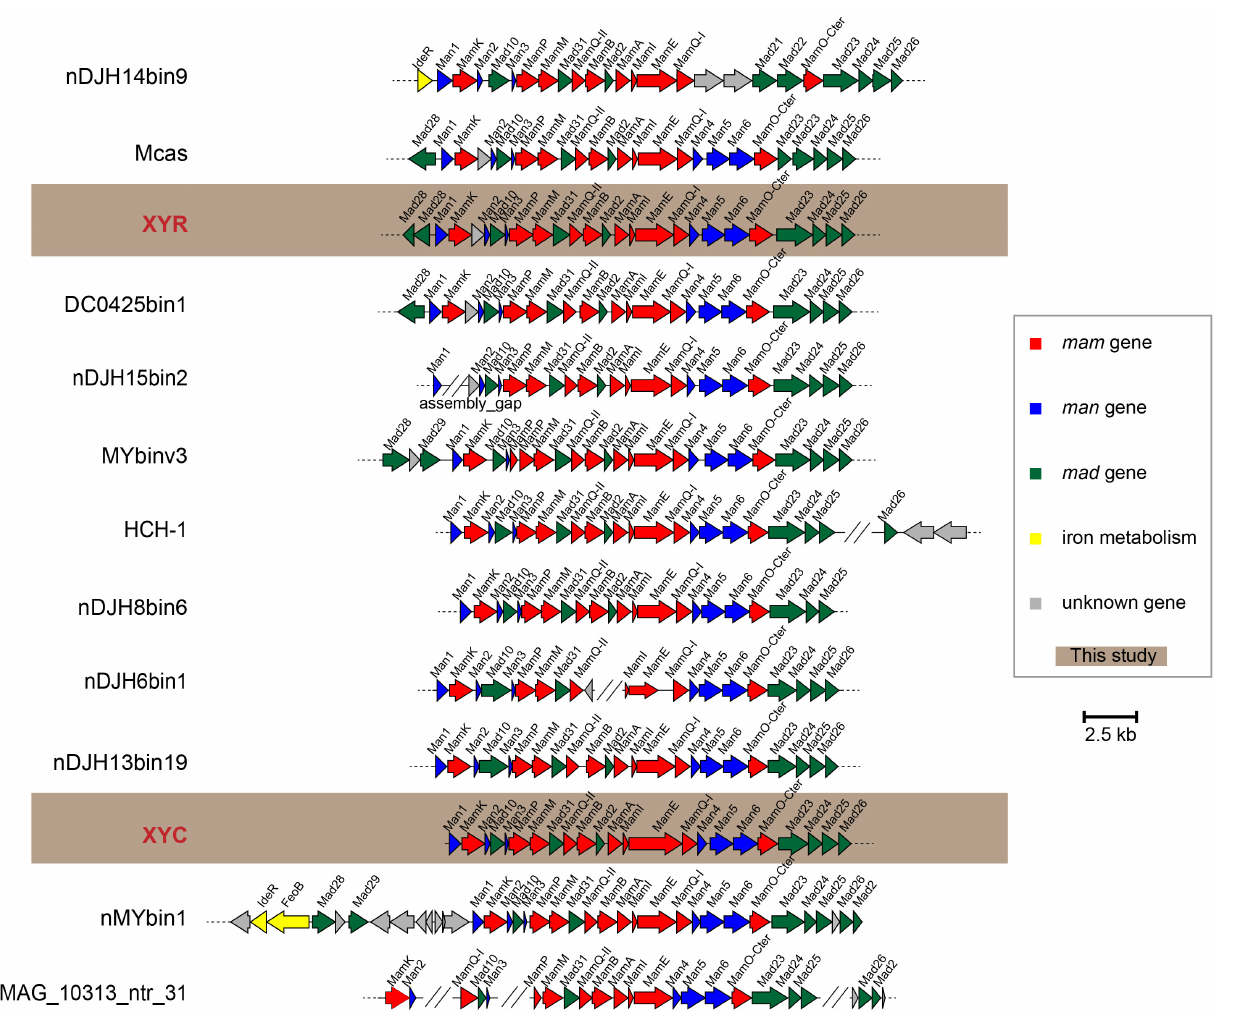
FIGURE 4 | Comparison of MGCs recovered in this study with previously reported representative MGCs. Mcas, Ca . Magnetobacterium casensis; HCH-1, Ca . Magnetominusculus xianensis strain HCH-1; XYR, Ca. Magnetobacterium cryptolimnobacter strain XYR; XYC, Ca. Magnetomicrobium cryptolimnococcus strain XYC; DC0425bin1, Nitrospirae bacterium DC0425bin1; nDJH15bin2, Nitrospirae bacterium nDJH15bin2; MYbinv3, Nitrospirae bacterium MYbinv3; nDJH8bin6, Nitrospirae bacterium nDJH8bin6; nDJH6bin1, Nitrospirae bacterium nDJH6bin1; nDJH13bin19, Nitrospirae bacterium nDJH13bin19; nMYbin1, Nitrospirae bacterium nMYbin1; and MAG_10313_ntr31, Nitrospirae bacterium